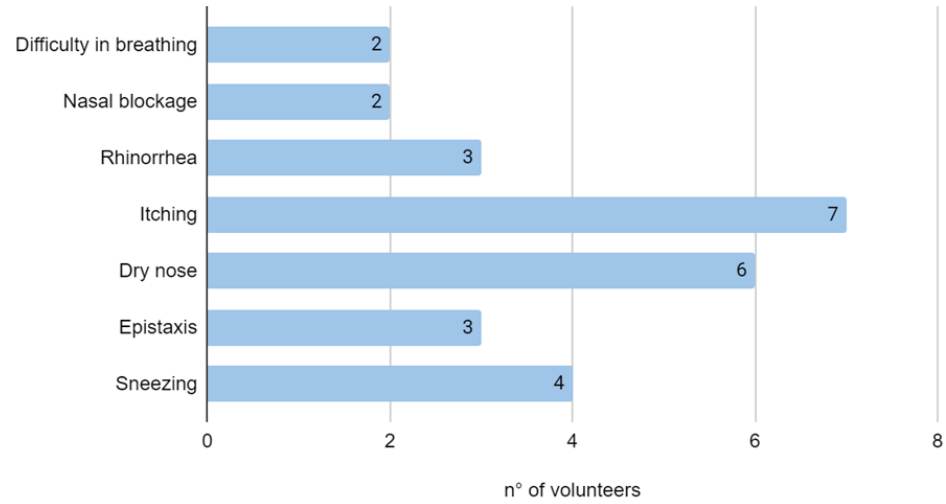
Figure 2. Symptoms reported by volunteers.